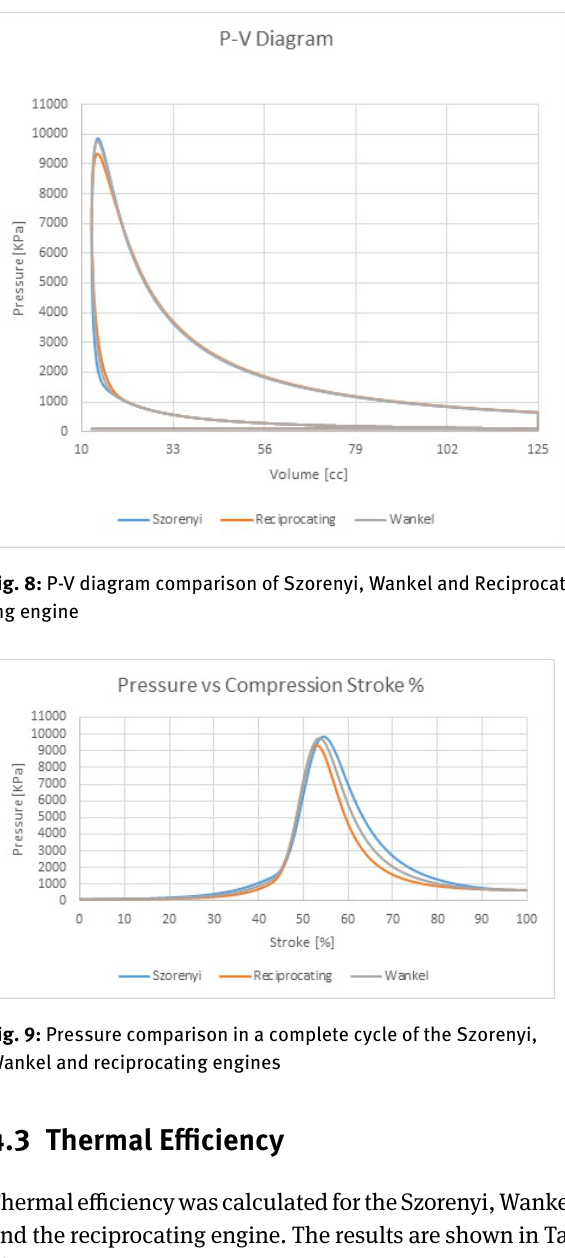
Table 3: Fuel conversion efficiency comparison between Szorenyi,